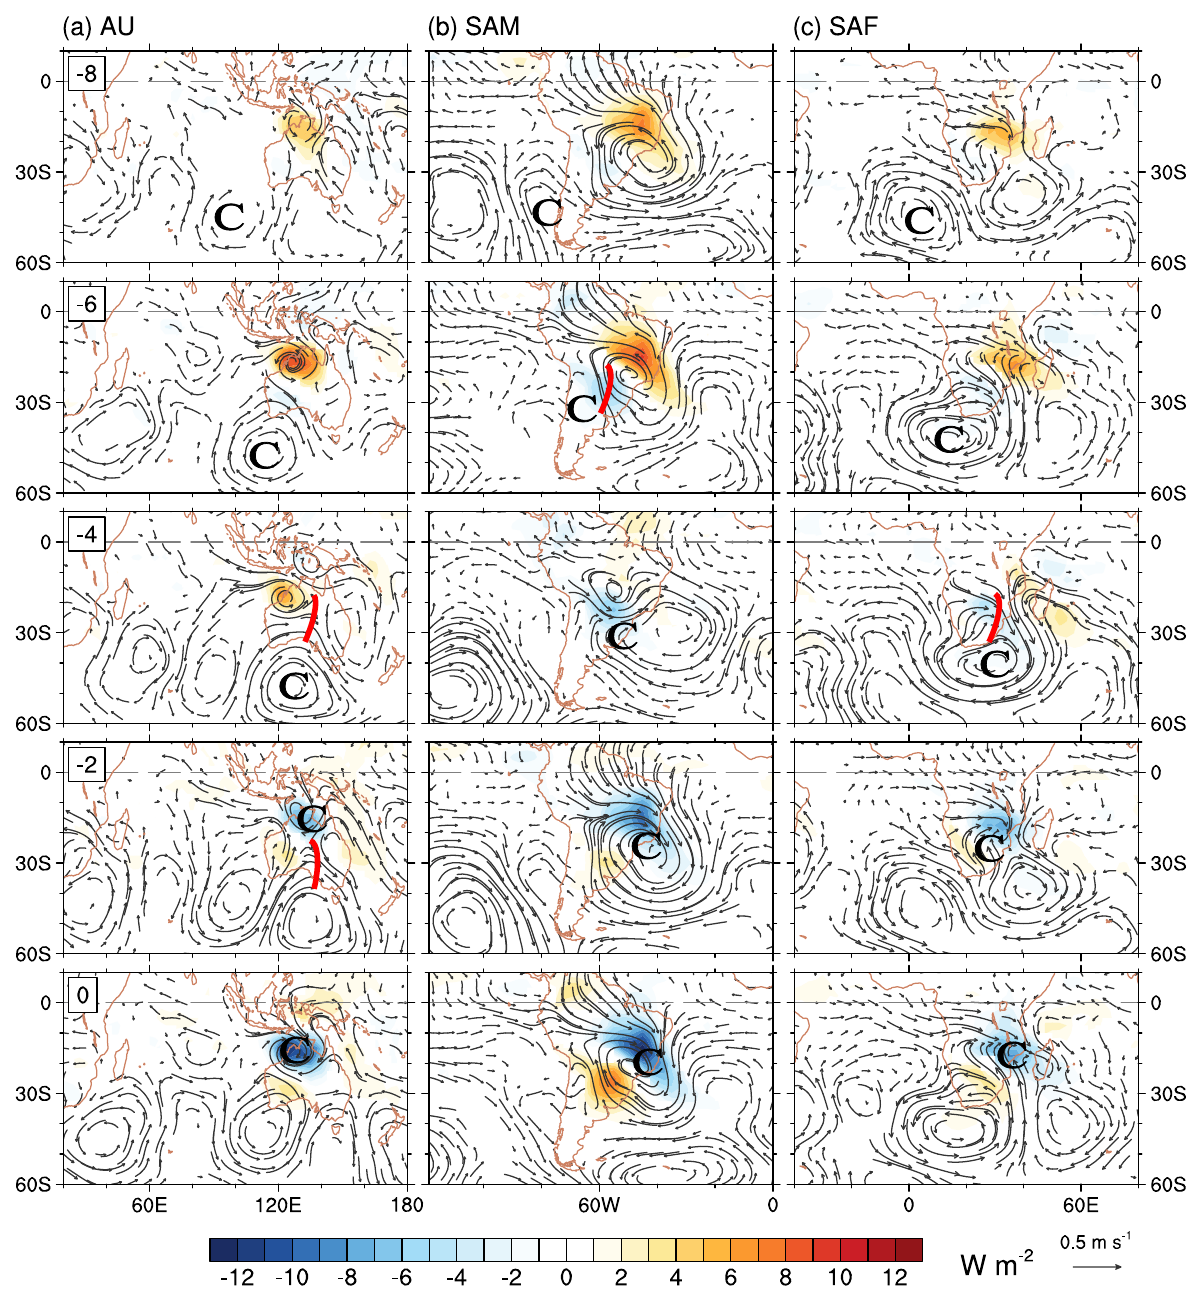
Fig. 5 Origins of 8 – 20-day ISVs of SH summer monsoons. Same as Fig. 4, except for 850-hPa wind anomalies in SH: a Australian (AU), b South American (SAM), and c South African (SAF) monsoons. The red line denotes the trough center at 850